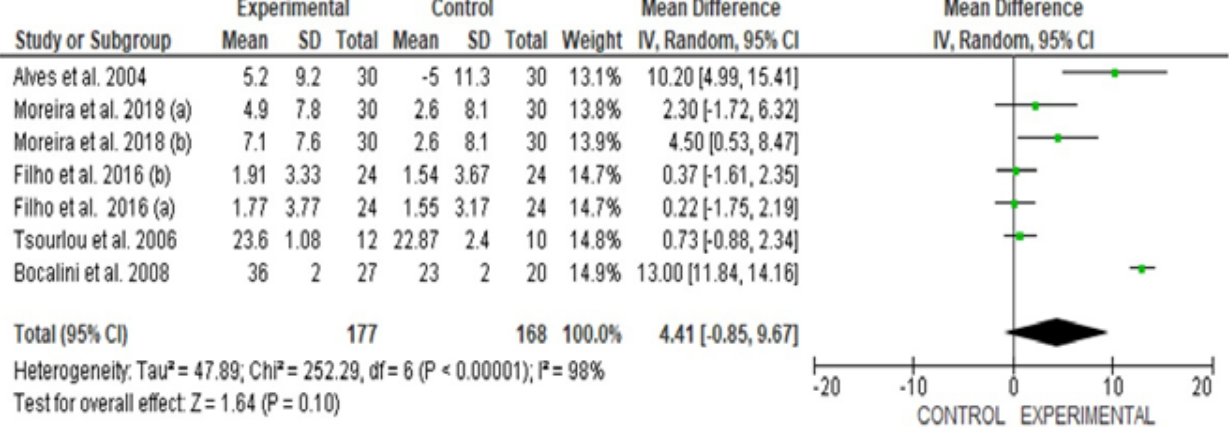
Figure 4. Forest plot of the seven results of the five studies selected for posterior muscle chain extensibility measured by the “Sit and Reach” test (cm) in the Rikli Jones test battery.